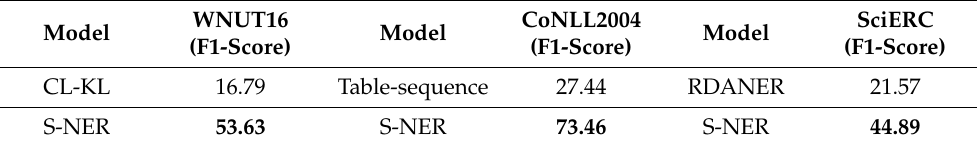
Table 2. Performance comparisons on test subsets across the three benchmark datasets, where the sentences of subsets consist of cascading label misclassifications. Bold values denote the best